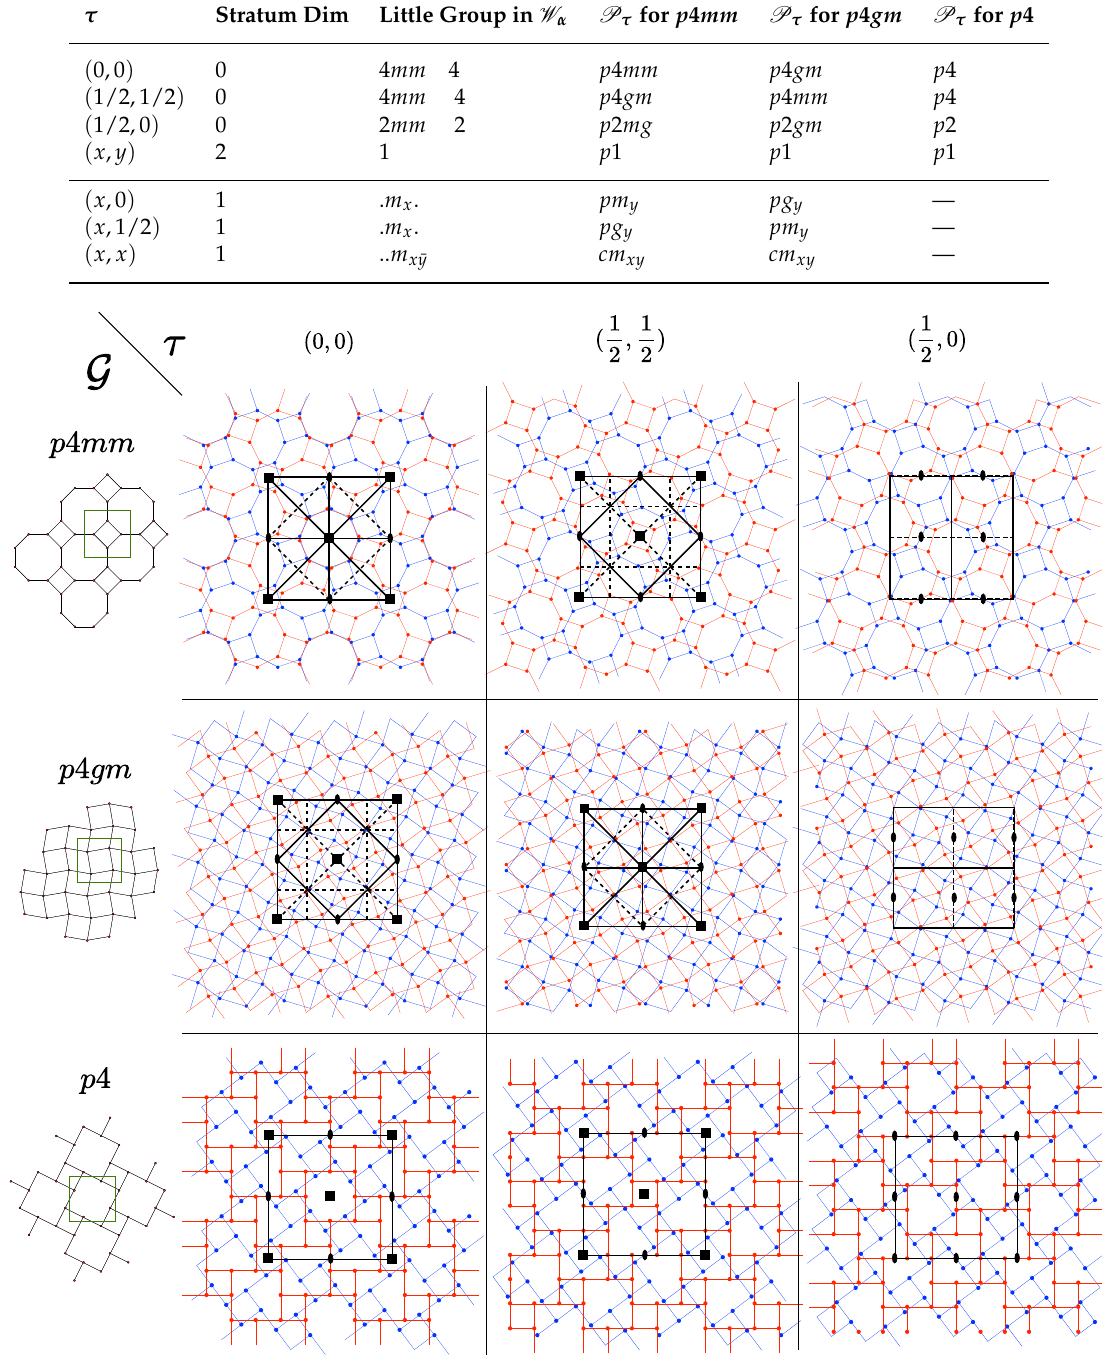
Table 1. The complete set of symmetry groups P τ for general square structures of space groups p 4 mm , p 4 gm and p 4 as function of the rigid-body translation τ . Structures of groups p 4 mm and p 4 gm share the same W α = p 4 mm and structures of group p 4, generating no exchange set, have W α = p 4. The coordinates of the translation τ are given with respect to the unit cell of the union group U α defined by U 1 = ( n , m ) / Σ and U 2 = ( − m , n ) / Σ with Σ = n 2 + m 2 . The (primitive) unit cell of the groups P τ are defined by T 1 = ( n , m ) and T 2 = ( − m , n ) .